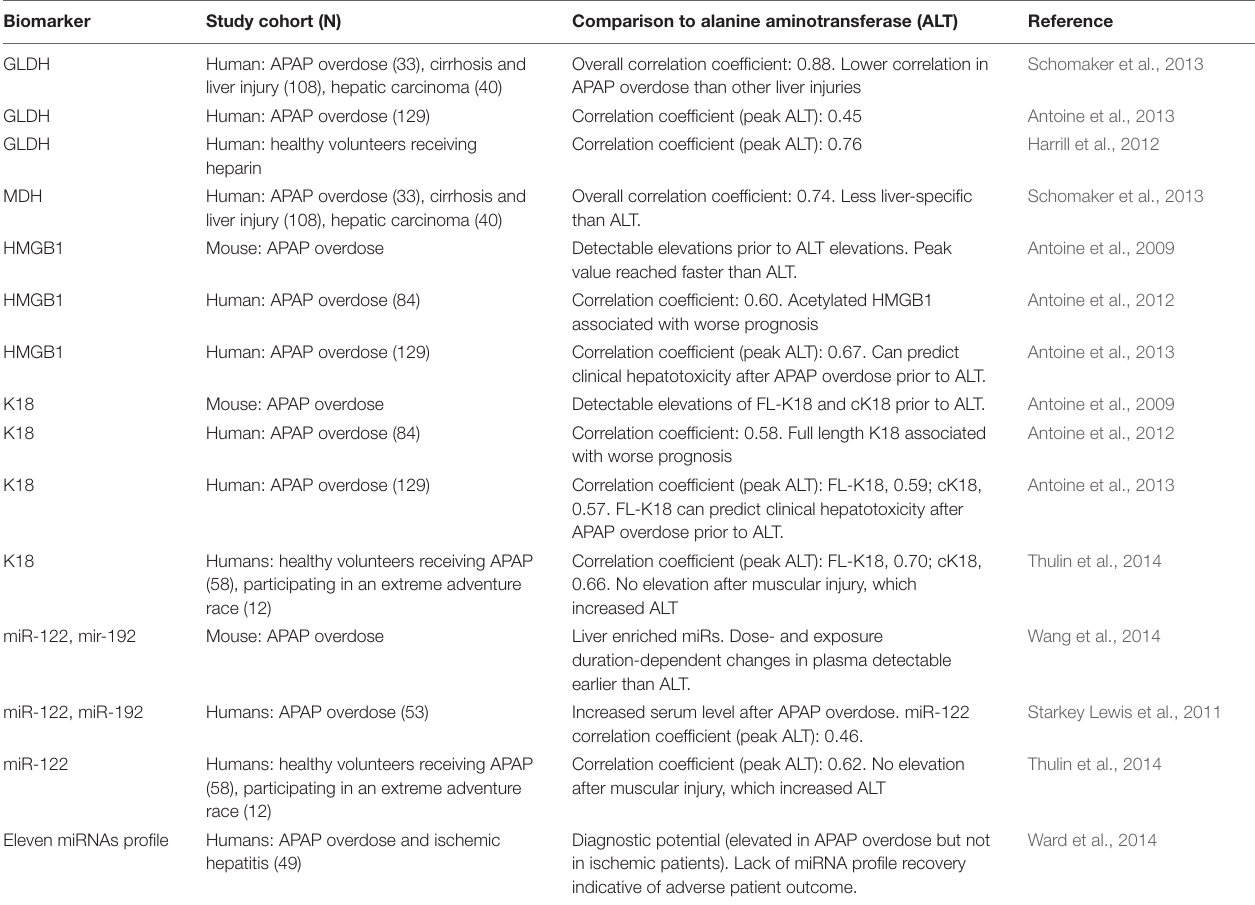
TABLE 1 | New serum/plasma DILI biomarker candidates. Biomarker Study cohort (N) Comparison to alanine aminotransferase (ALT)